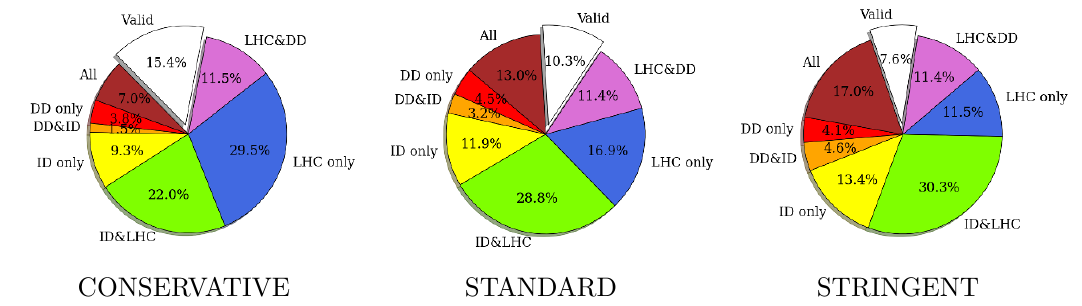
Figure 21 . Fraction of the pMSSM points satisfying the light Higgs mass, relic density, LEP and (cid:13)avour constraints excluded by direct and indirect detections and LHC